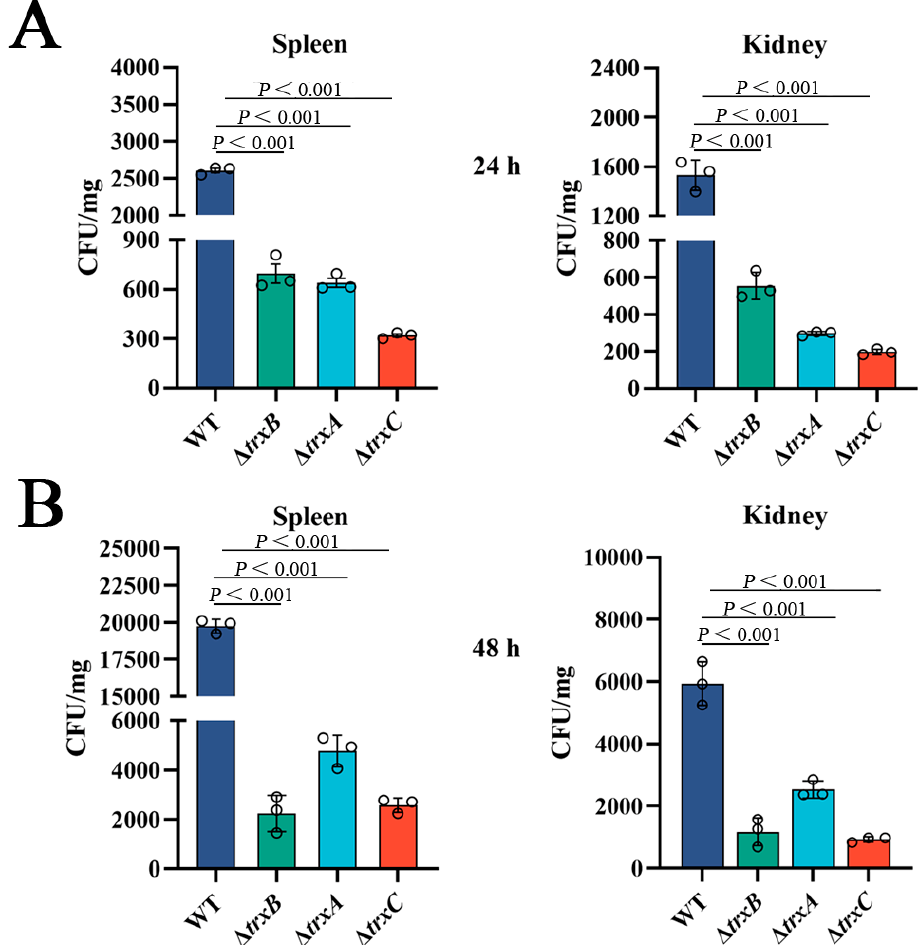
Figure 6. Effects of the thioredoxin system mutations on bacterial virulence. ( A ) Edwardsiella piscicida strains (WT, Δ trxB , Δ trxA , and Δ trxC ) were used to infect tilapias, then, after 24 h, bacteria recovery from immune tissues (spleen and kidney) was analyzed by plate counting. ( B ) 48 h post-infection, bacteria were counted by plate counting. Data are presented as the means ± SEM (N = 3). N, the number of times the experiments were performed. p values were obtained by analysis of variance using SPSS 23.